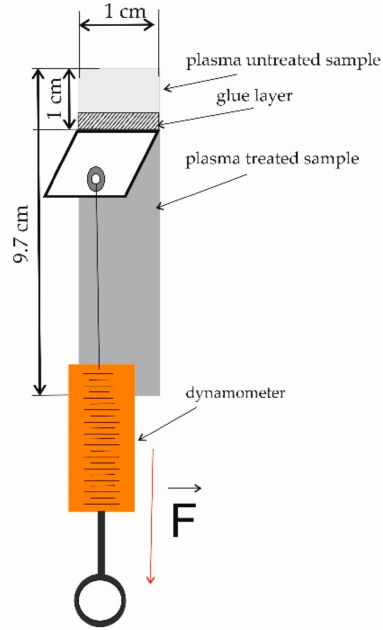
Figure 2. Scheme of the adhesive strength